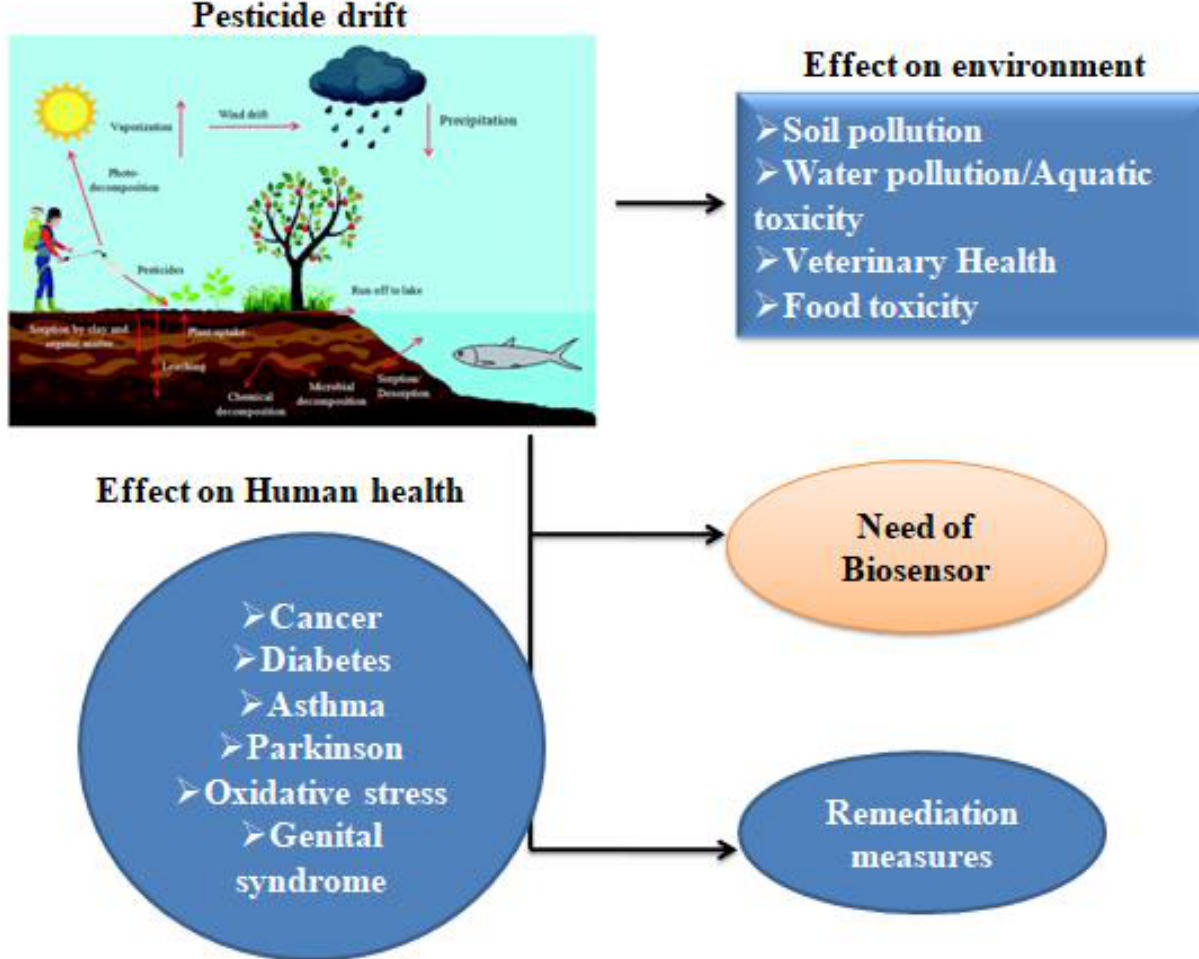
Figure 2. Drifting of pesticides into the environment and its toxic effect.